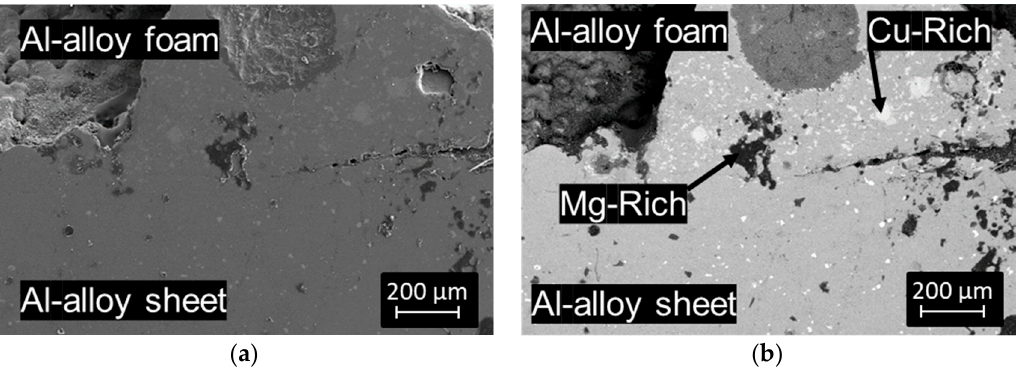
Figure 5. SEM and back-scattered images of Al-alloy foam/Al-Cu-Mg/Al-alloy sheet interface. ( a ) Higher-magnification micrograph in secondary electron mode. ( b ) Micrograph in backscattered electron mode. Arrows indicate spot EDS analysis.